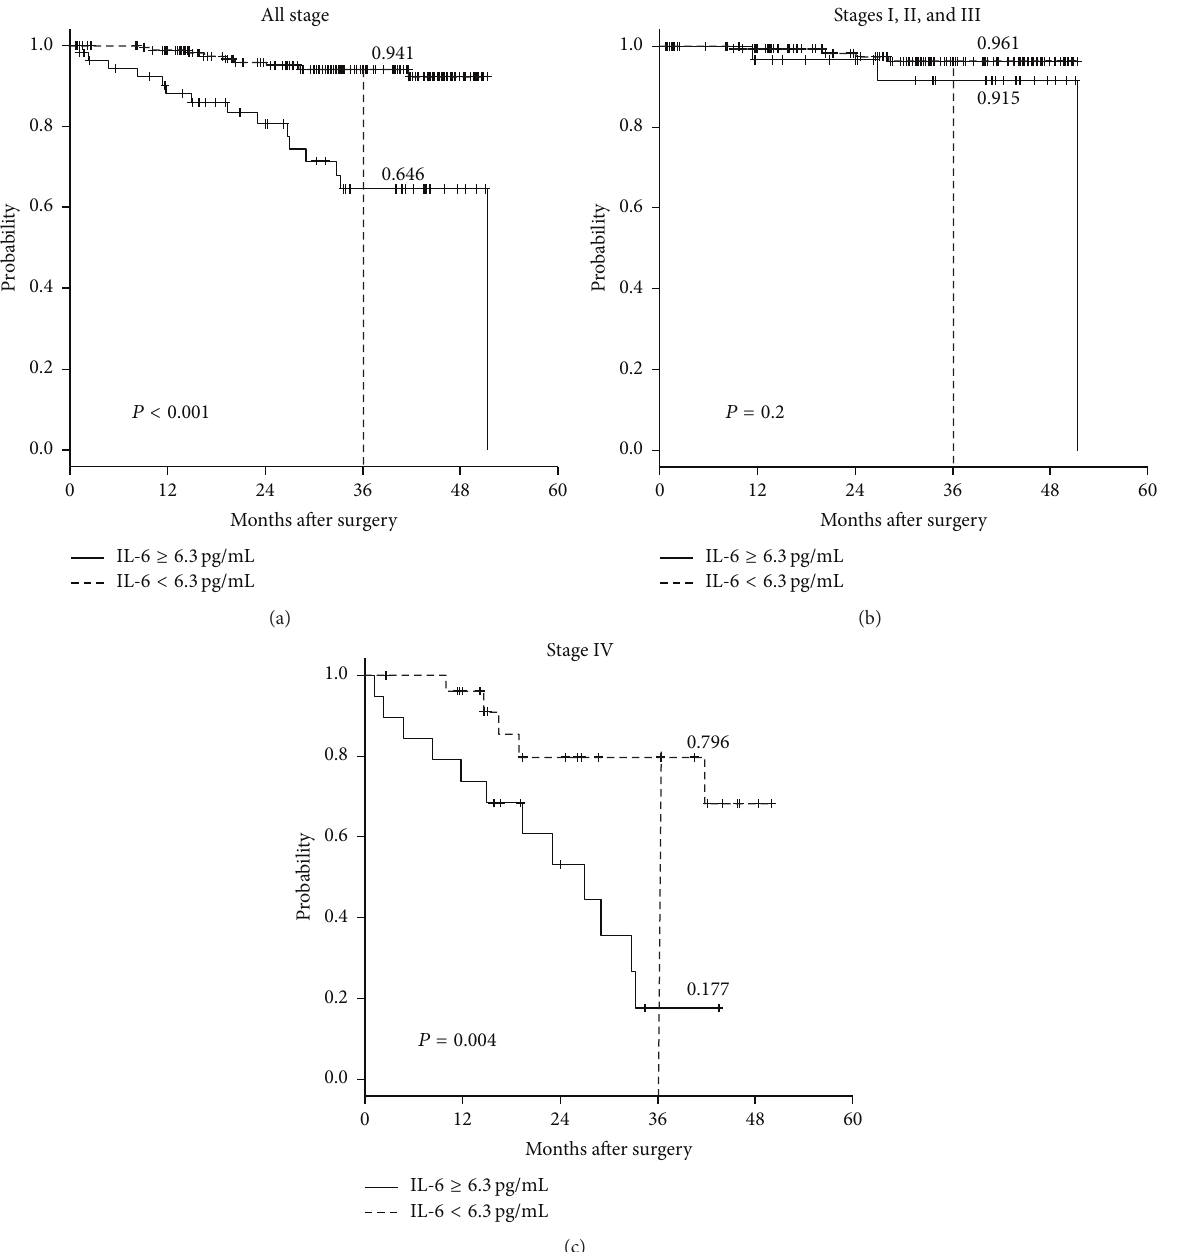
Figure 2: Three-year overall survival (OS) rates according to the preoperative serum interleukin-6 (IL-6) status (Kaplan-Meier analysis). (a) OS of all 233 patients. (b) OS of the 188 stages I–III colorectal cancer patients. (c) OS of the 45 stage IV patients.